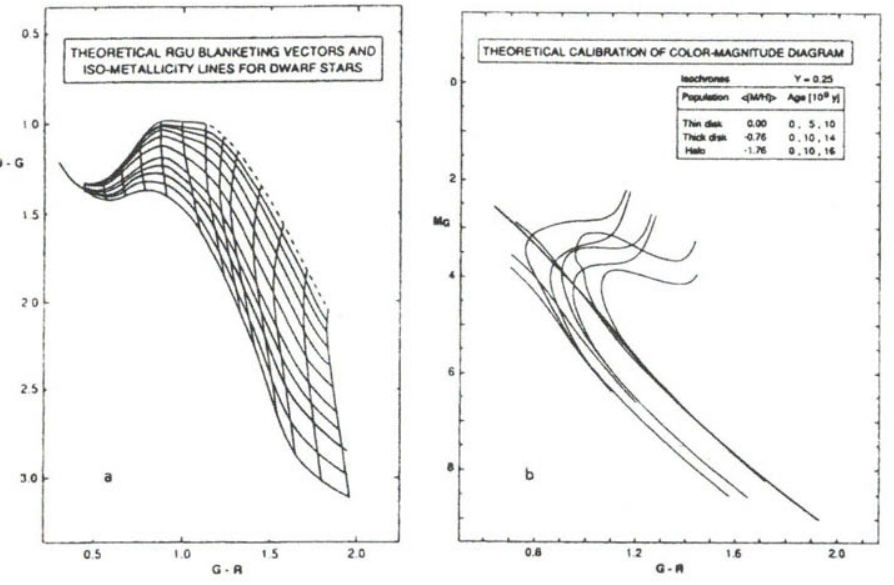
Fig. 4. (a) The two-color diagram for dwarf stars, based on transfor- mations of UBV standard data and on synthetic photometry from theoret- ical model atmospheres and isochrone calculations, (b) Color-magnitude diagram for dwarf and subgiant stars, based on transformations of UBV standard data and on synthetic photometry from theoretical model atmo- spheres and isochrones (Buser and Fenkart